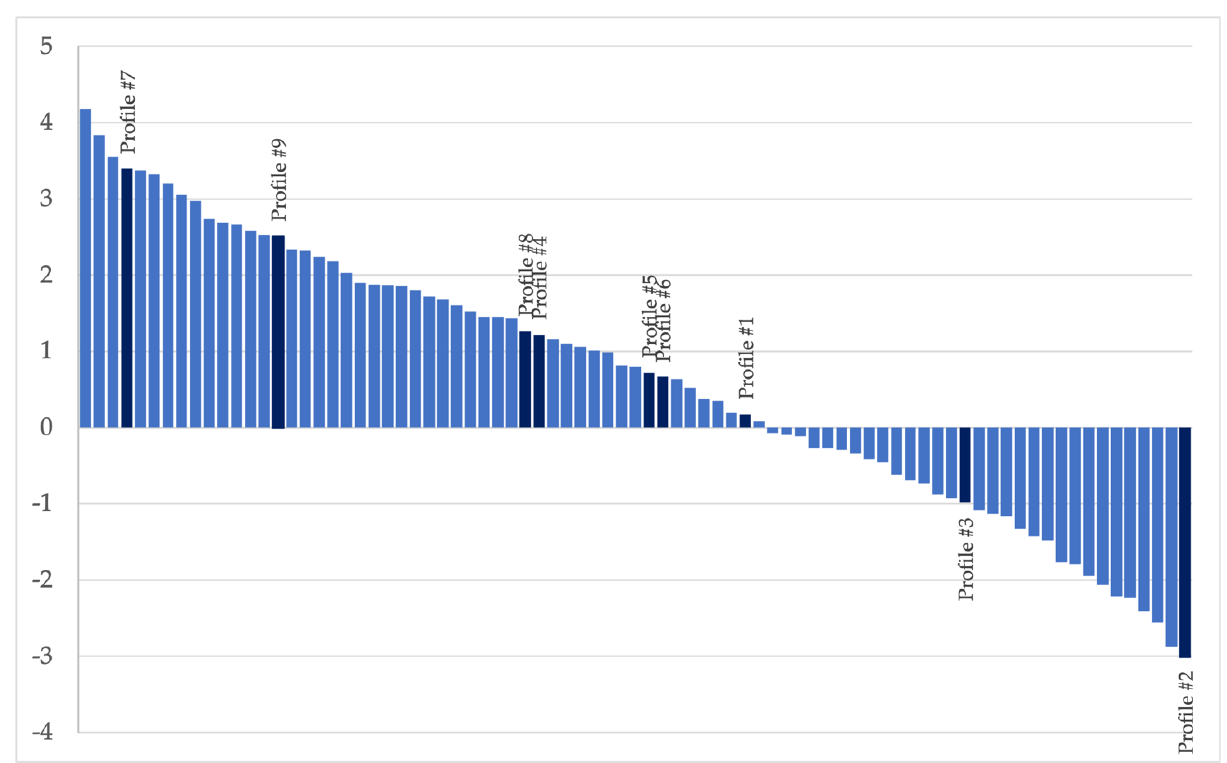
Figure 3. Distribution of the utility of each product profile included (dark blue) vs. not included in the survey (light blue).